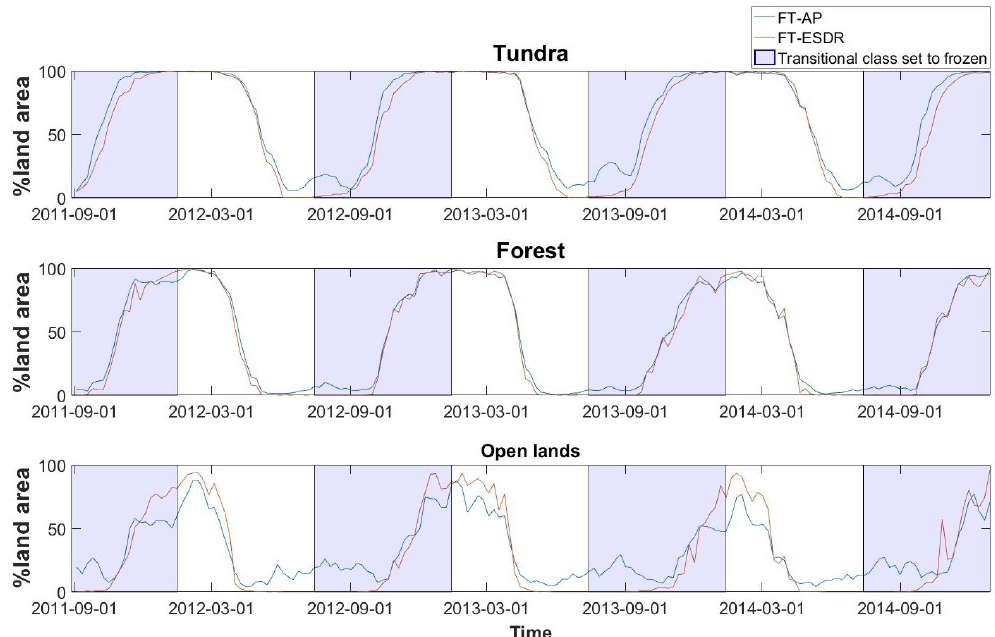
Figure 3. Time series of percentage of frozen grid cells for FT-AP and FT-ESDR for the three land covers (tundra, forest and open lands).